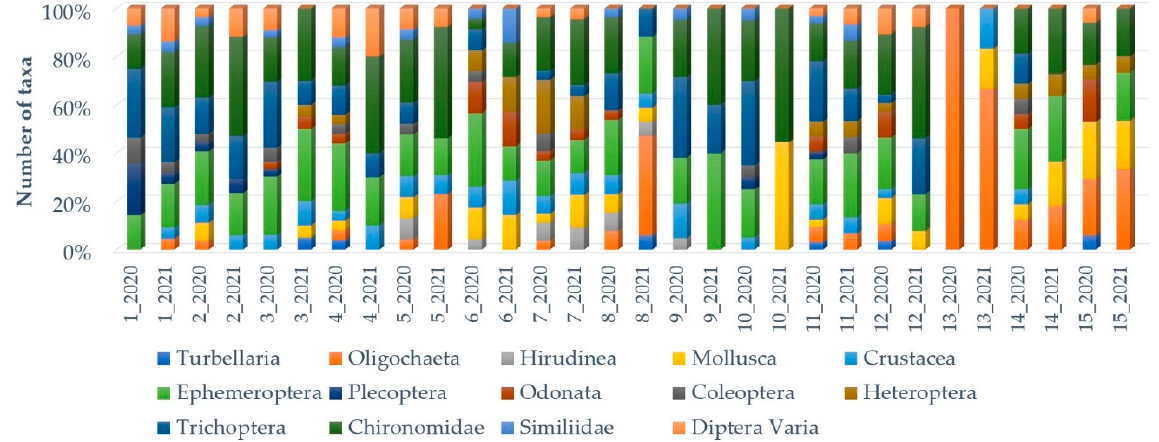
Figure 5 . Percentage ratio of the major taxonomic groups at the studied sites in 2020 and 2021.